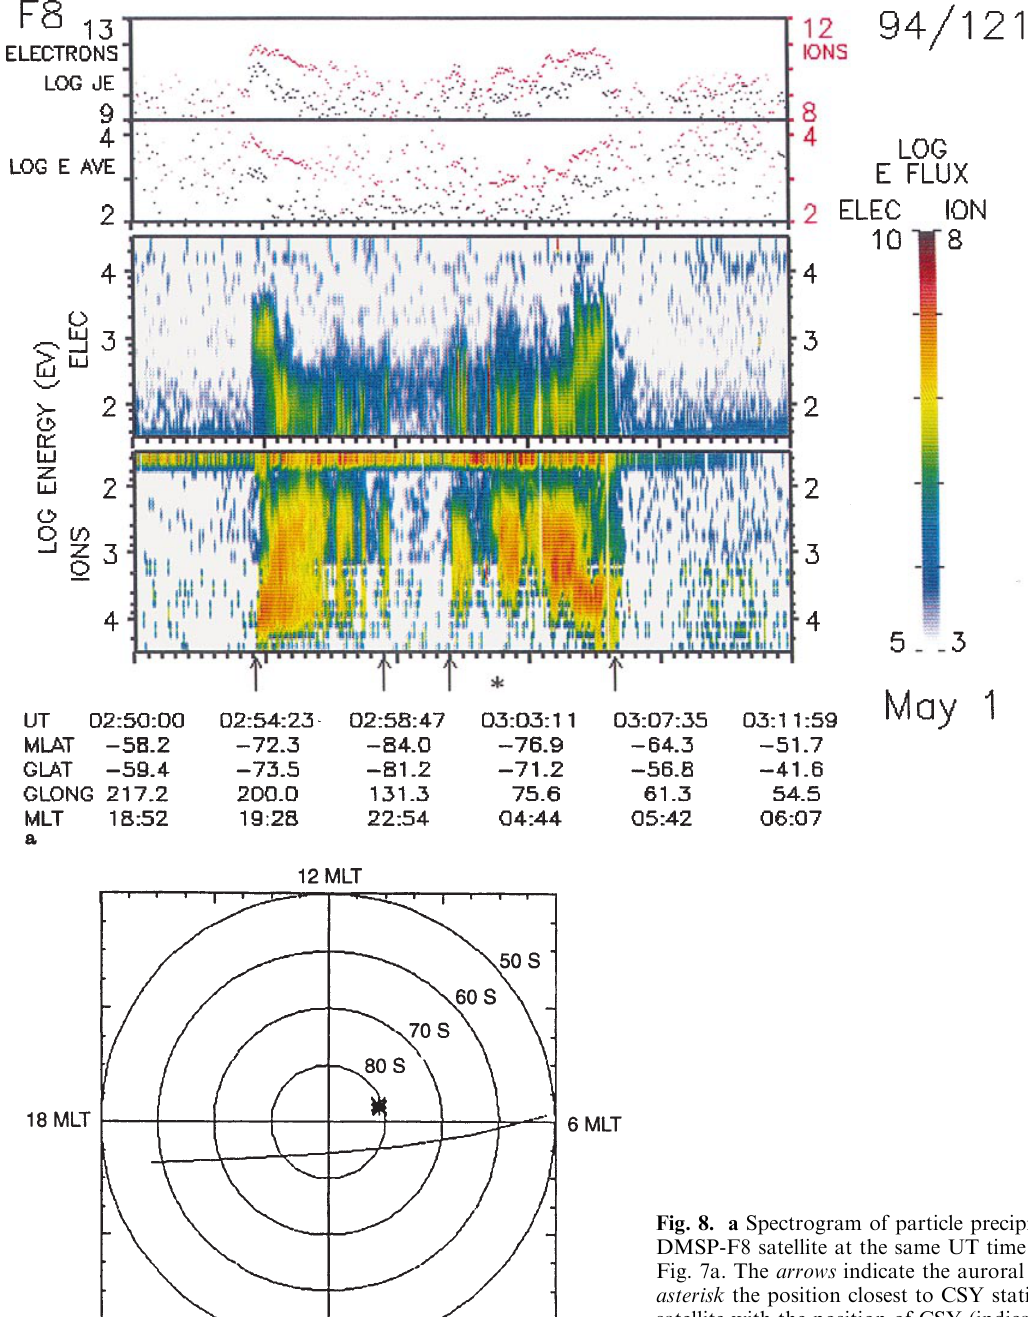
Fig. 8. a Spectrogram of particle precipitation measured by DMSP-F8 satellite at the same UT time as the event displayed in Fig. 7a. The arrows indicate the auroral oval boundaries and the asterisk the position closest to CSY station. b Pass of DMSP-F8 satellite with the position of CSY (indicated by *) during UT time displayed in